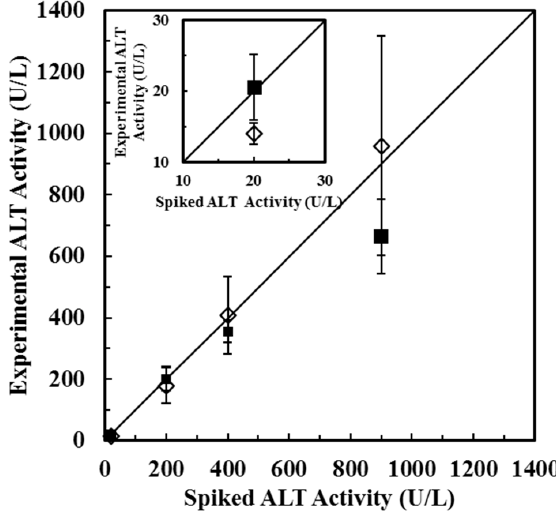
Figure 9. Experimental ALT activities measured by Method 1 ( ◊ ) and Method 2 ( ■ ) at spiked ALT activities: 20 U/L, 200 U/L, 400 U/L, and 900 U/L ( N = 5). The inset plot shows lower activity range.